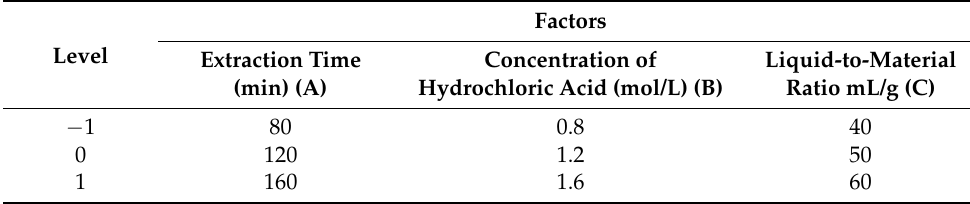
Table 1. Three-factor and three-level response surface